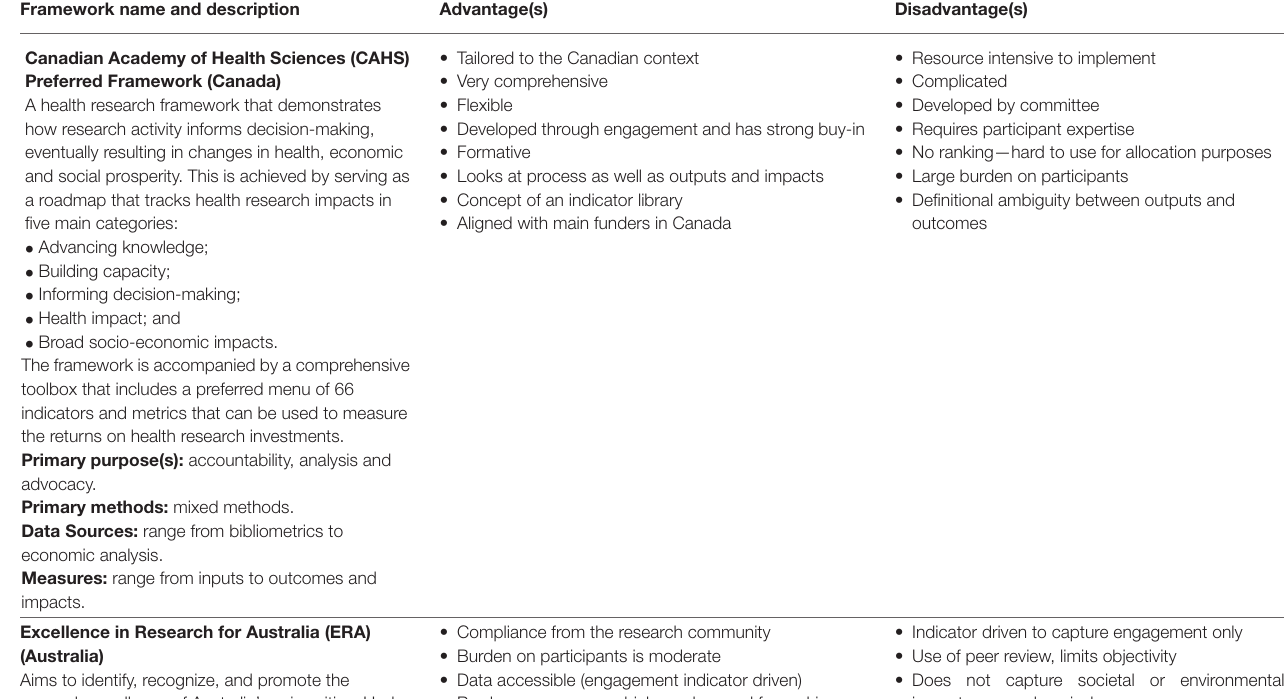
TABLE 1 | Sample of Research Impact Assessment